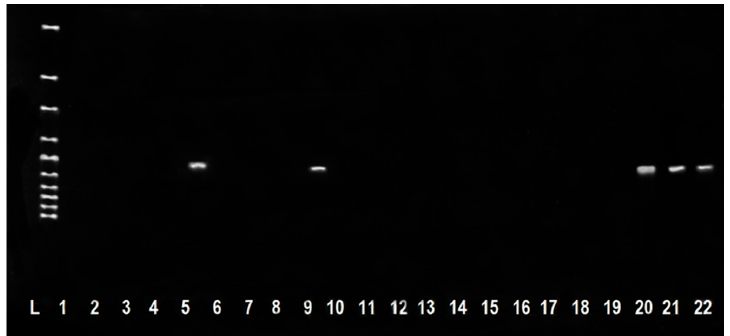
Figure 2. Detection of mecA gene in S. chromogenes isolates isolated from sheep’s cheese (527 bp). L: 100 bp ladder; Line 1: water (negative control); Lines 5,9,20,21: isolates S. chromogenes with mecA gene; Lines 2, 3, 4, 6, 7, 8, 10, 11, 12, 13, 14, 15, 16, 17, 18, 19: isolates S. chromogenes without mecA gene; Line 22: reference strain CCM 4750 S. aureus (positive